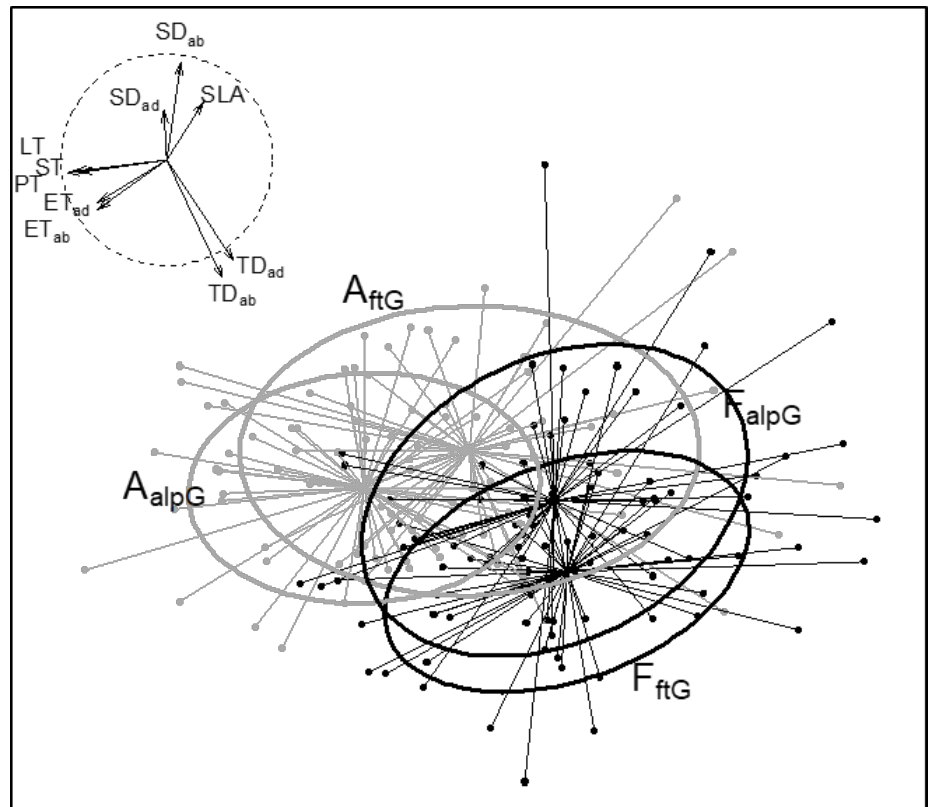
Figure 2. Effects of ecotype and environment on leaf anatomy in A. arenosa . Individuals from alpine (A, grey) and foothill (F, black) A. arenosa populations were grown in an alpine common garden (alpG) and a foothill common garden (ftG). Principal component analysis was conducted using leaf anatomical traits, i.e., total leaf thickness (LT), palisade parenchyma thickness (PT), spongy parenchyma thickness (ST), mean thickness of the epidermis on adaxal (ET ad ) and abaxial (ET ab ) leaf surfaces and mean stomatal density on adaxial (SD ad ) and abaxial (SD ab ) leaf surfaces. Variables were transformed to achieve normal distribution, scaled and centered. Confidence ellipses were defined by the centroid and SD of the cloud. Axes represent 39.4% ( x -axis) and 16.3% ( y -axis) of the explained variance. Inset: arrows in the dashed circle were obtained by a second projection and indicate the contribution of traits to the separation along the principal components.